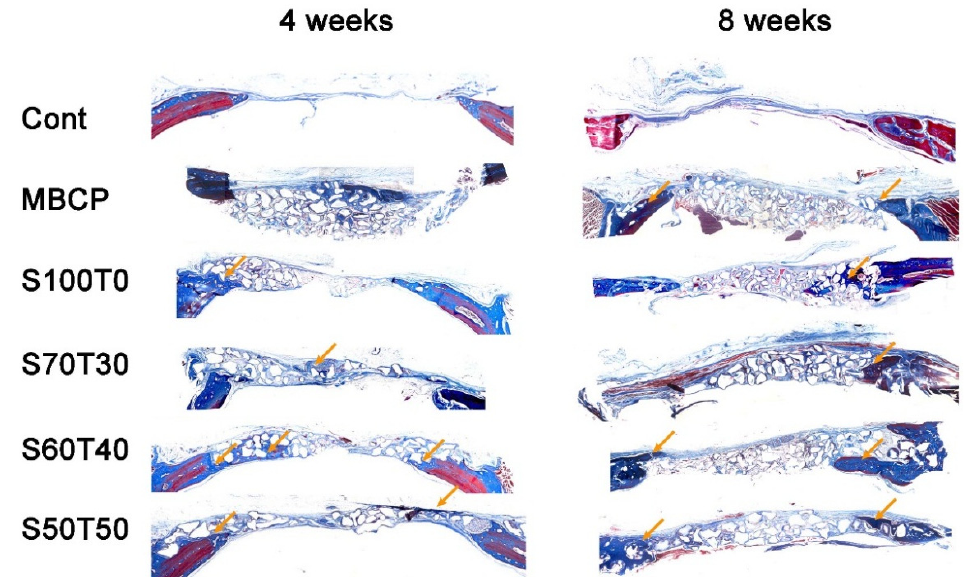
Figure 2. Histological slides with Masson’s Trichrome staining (four weeks and eight weeks).